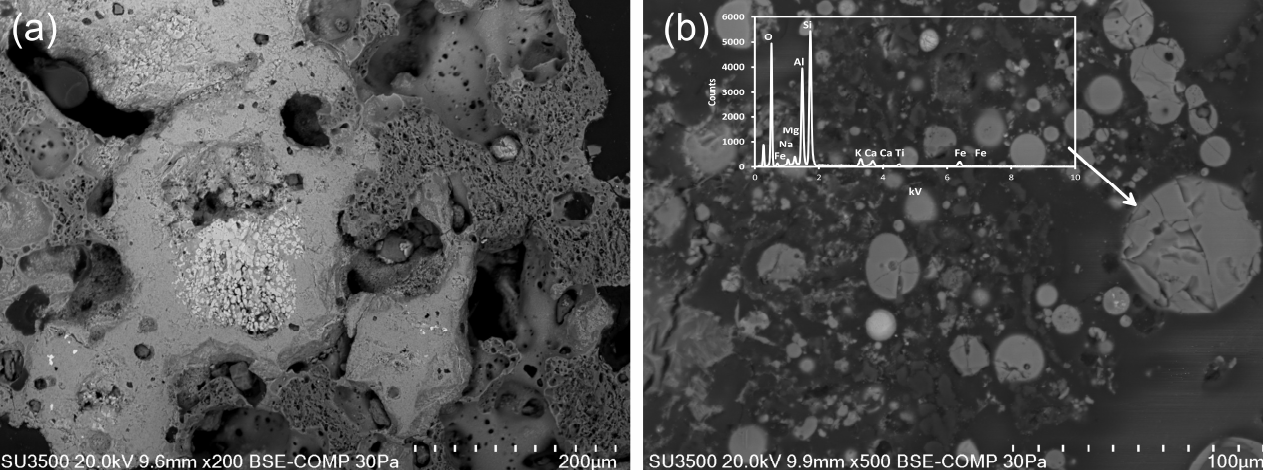
Figure 4. Positions of the tested samples in the Vassilev’s phase-mineral classification system [47]. 3.2.2. Main Chemical Components In the HTA ash sample (LWMAS), SiO 2 and Al 2 O 3 were present in the largest amount; their share in total amounted to over 63%. The content of SiO 2 in the analyzed sample was 42.30%, and Al 2 O 3 was 20.79%. The other chemical components were Fe 2 O 3 , CaO, MgO, and K 2 O, and totaled a few percent. The remaining components, i.e., MnO, Na 2 O, TiO 2, and P 2 O 5 , were present in amounts below 1%. LWMAS sample had a signif- icant amount of SO 3 , over 21%, and had a loss on ignition (LOI) of 1.64% (Table 3).